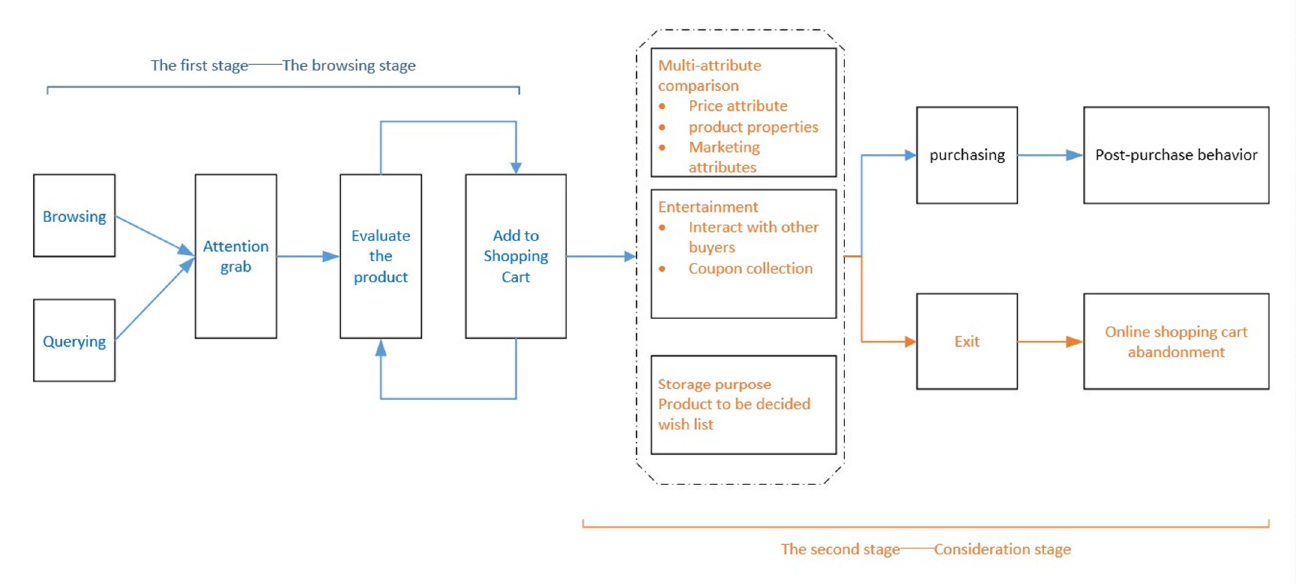
Figure 1. Online consumer buying decision process.